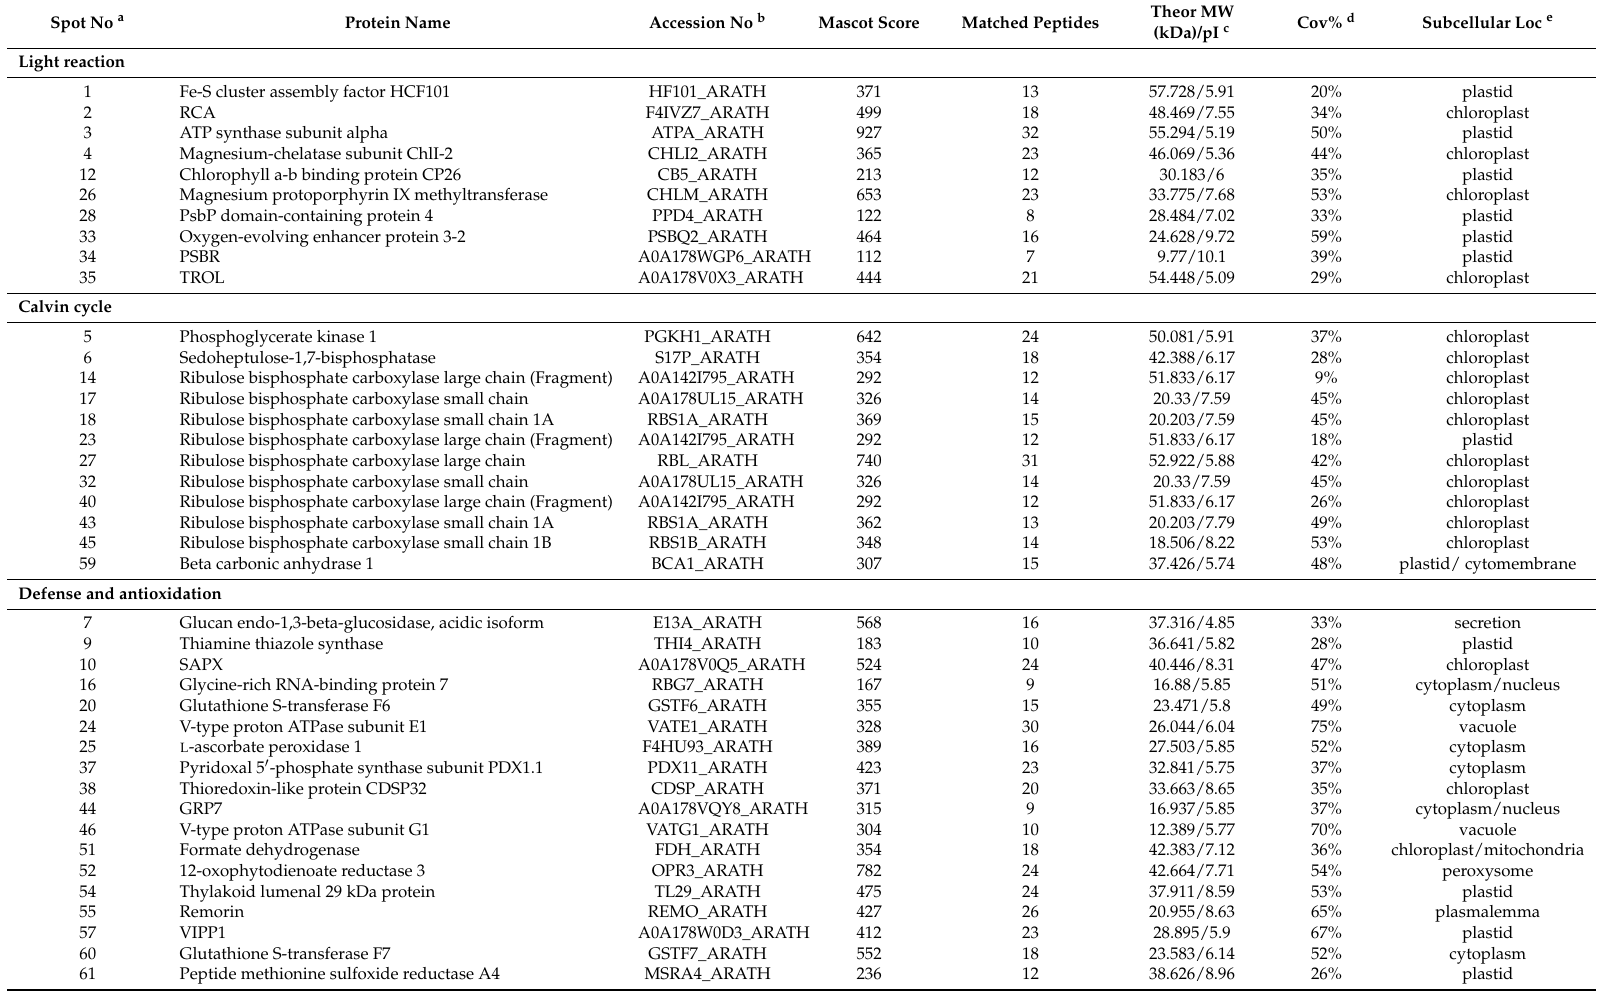
Table 1. Differential proteins identified by MALDI-TOF/TOF-MS of why1/3-var and CIPK14-var